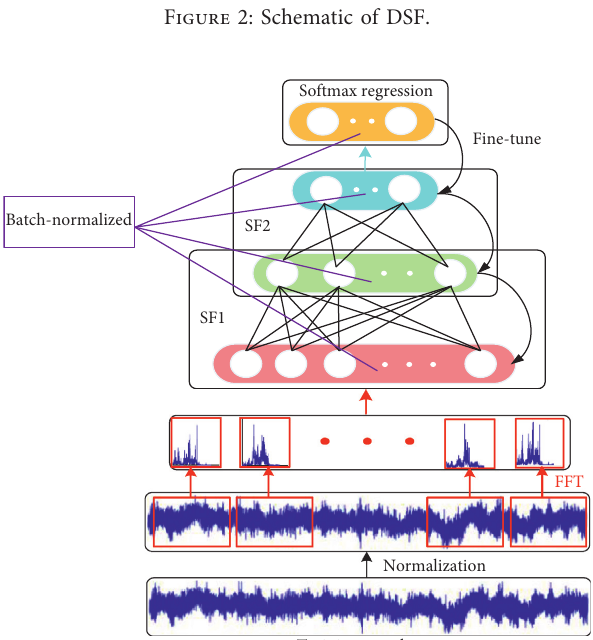
Figure 3: Intelligent fault diagnosis framework based on